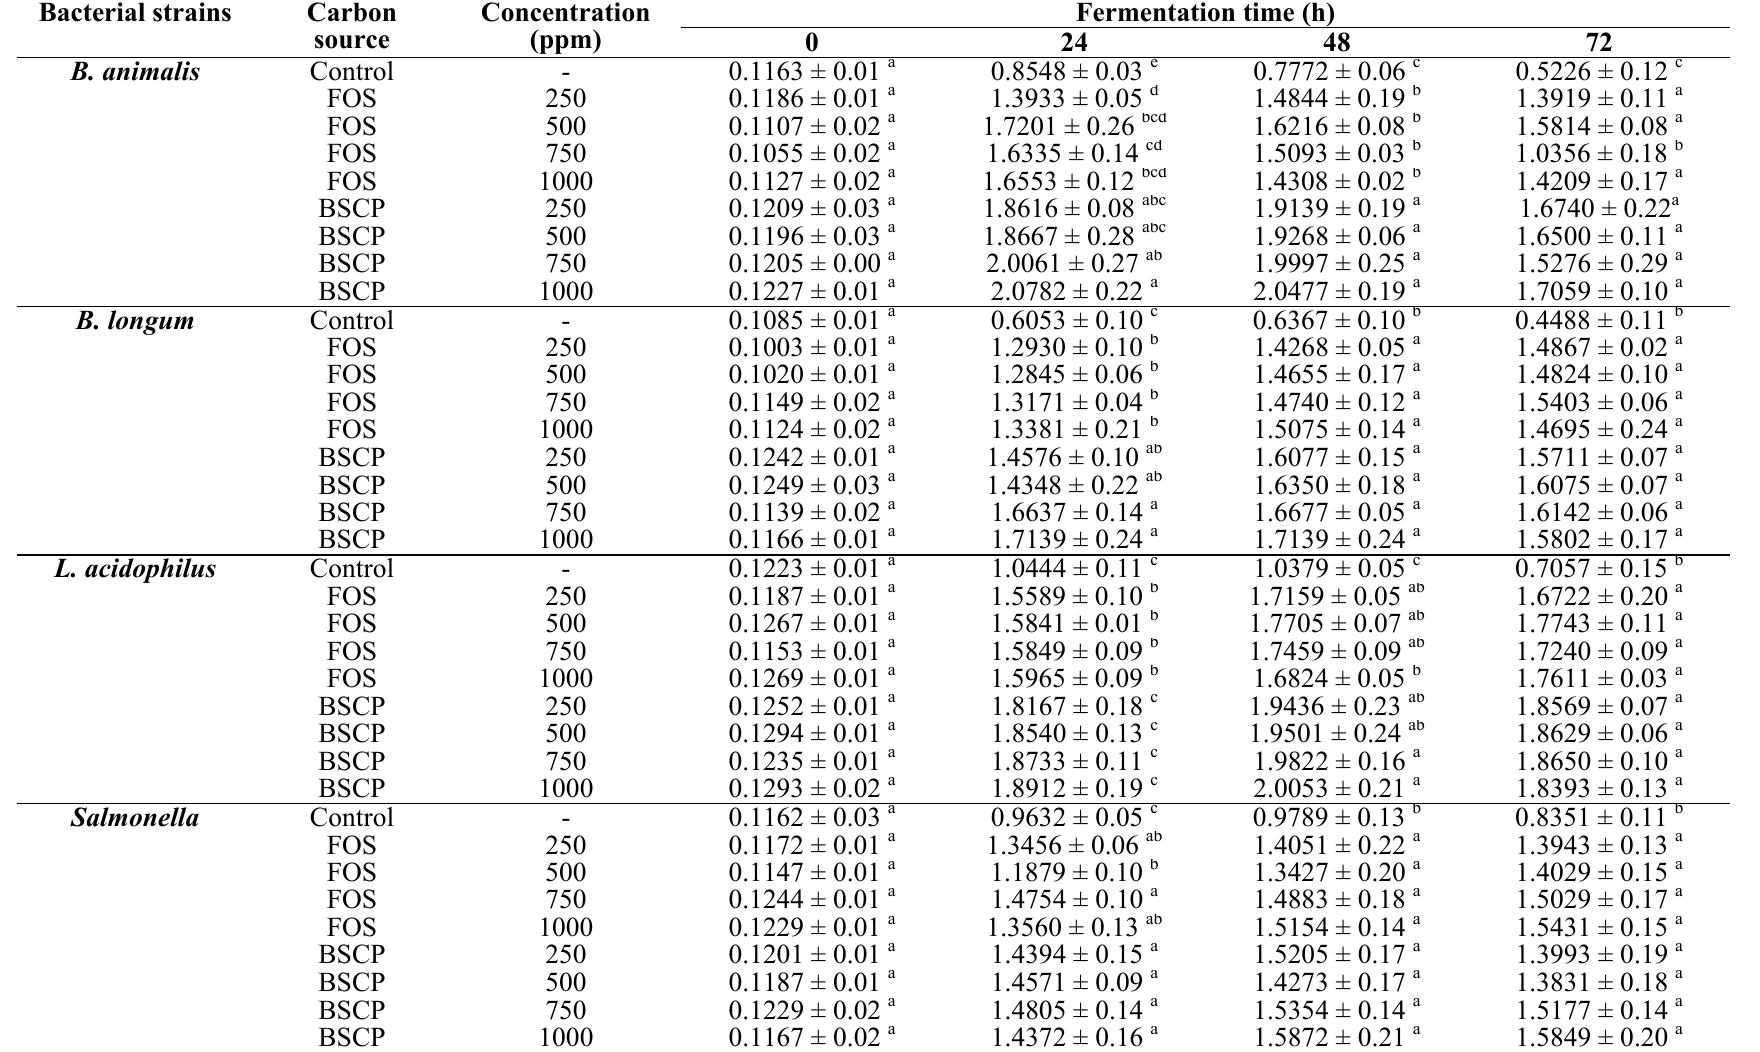
Table 1. Cell density of selected probiotics and S almonella sp. over fermentation time (at 600